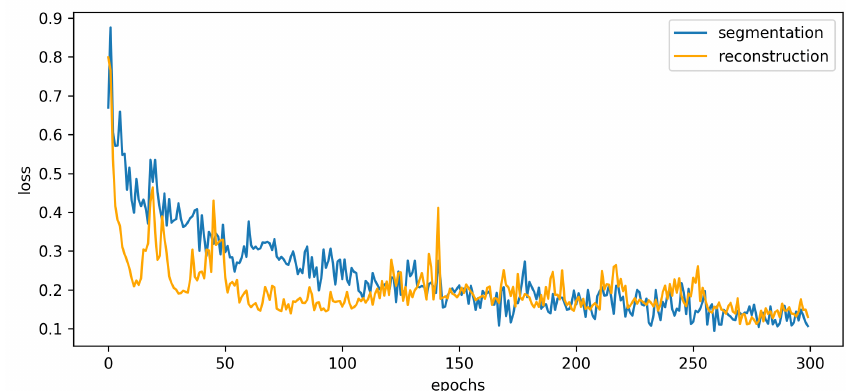
Figure 4. The training loss of the segmentation